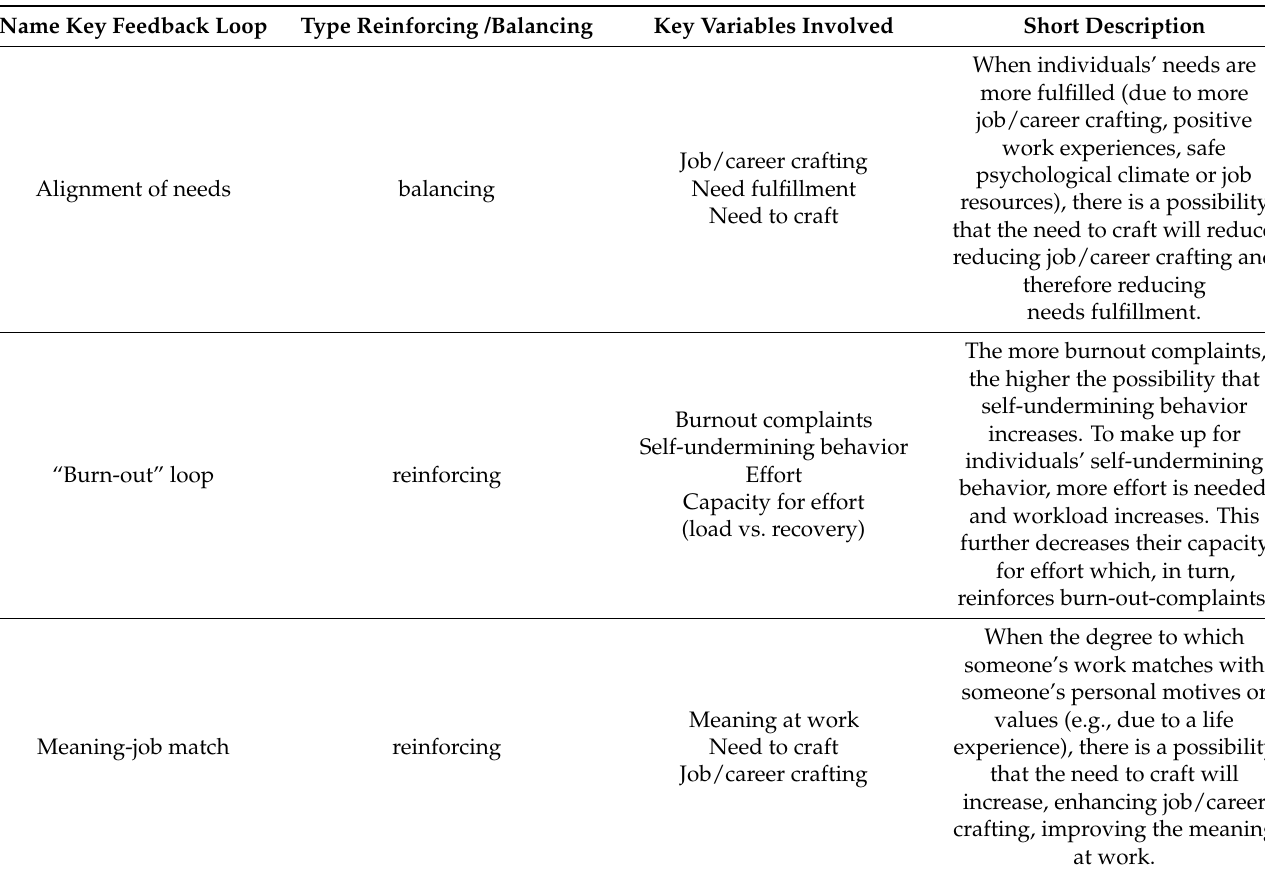
Table 2. Key feedback loops underlying workplace well-being, type, key variables involved, and short